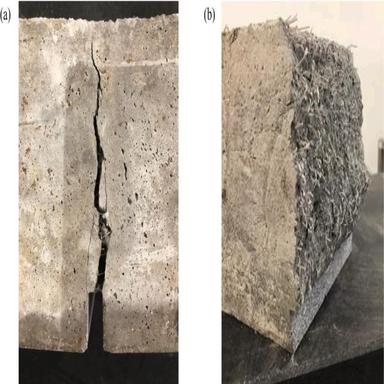
Mortar M1 after three points bend tests: (a) crack patterns; (b) detail of the collapse surface.